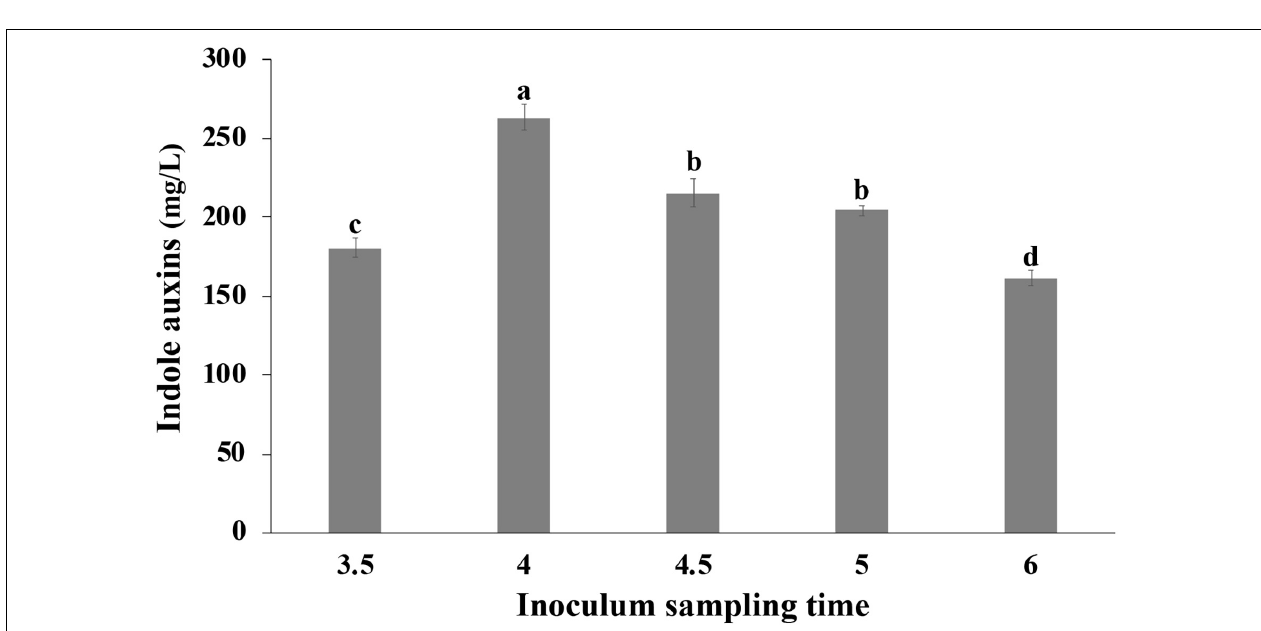
FIGURE 8 | Growth pattern and pH evolution during batch scale tests in YES medium under aerobic conditions at 30 ◦ C. Data points are mean values of duplicate fermentations.